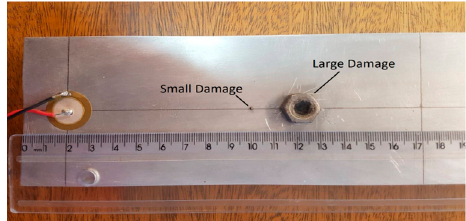
Figure 1. Monitored structure, the piezoelectric diaphragm, the sphere (small damage) and the steel nut (large